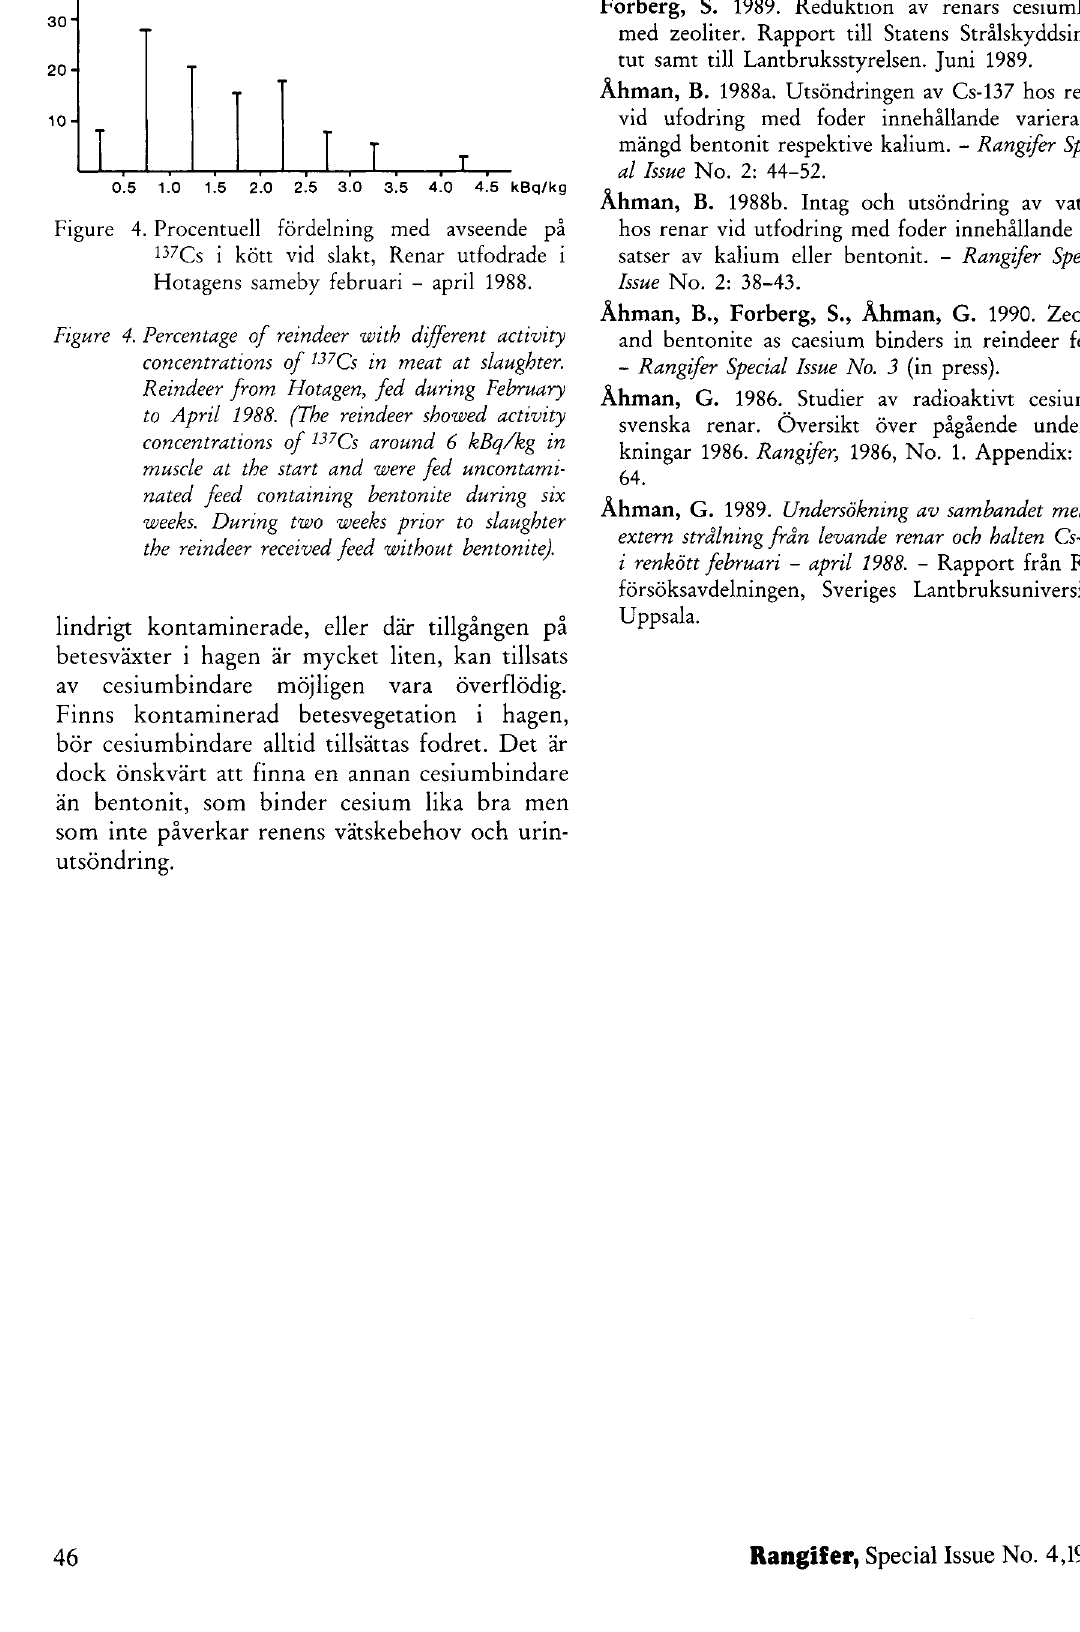
Figure 4. Procentuell fordelning med avseende pa 137 Cs i kott vid slakt, Renar utfodrade i Hotagens sameby februari - april 1988. Figure 4. Percentage of reindeer with different activity concentrations of 137 Cs in meat at